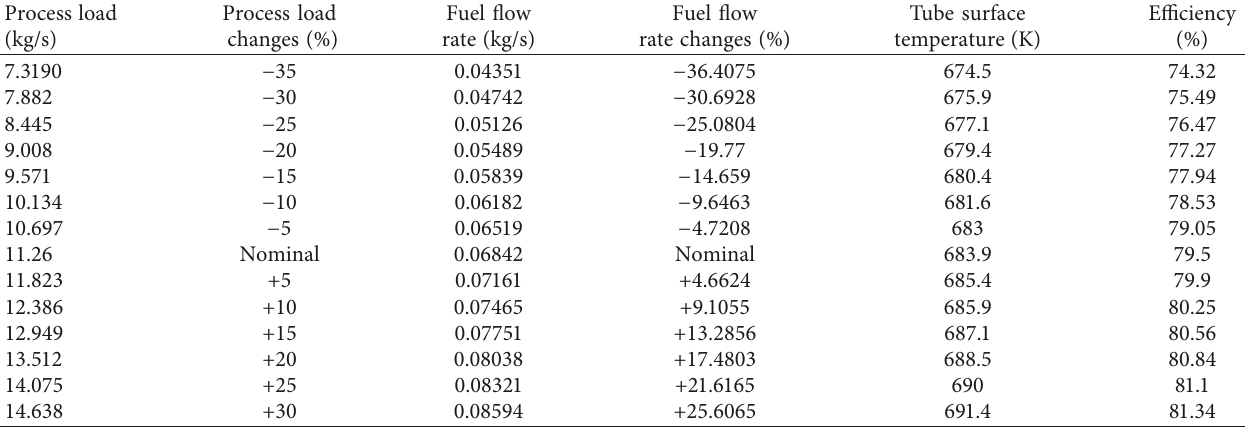
Table 5: Fuel flow rate changes versus furnace load for economic operation evaluation.